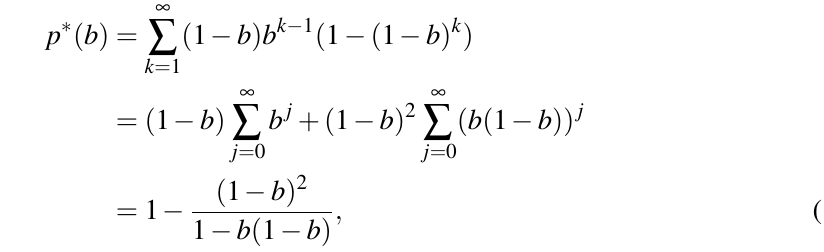
Fig. 4. The plot of p